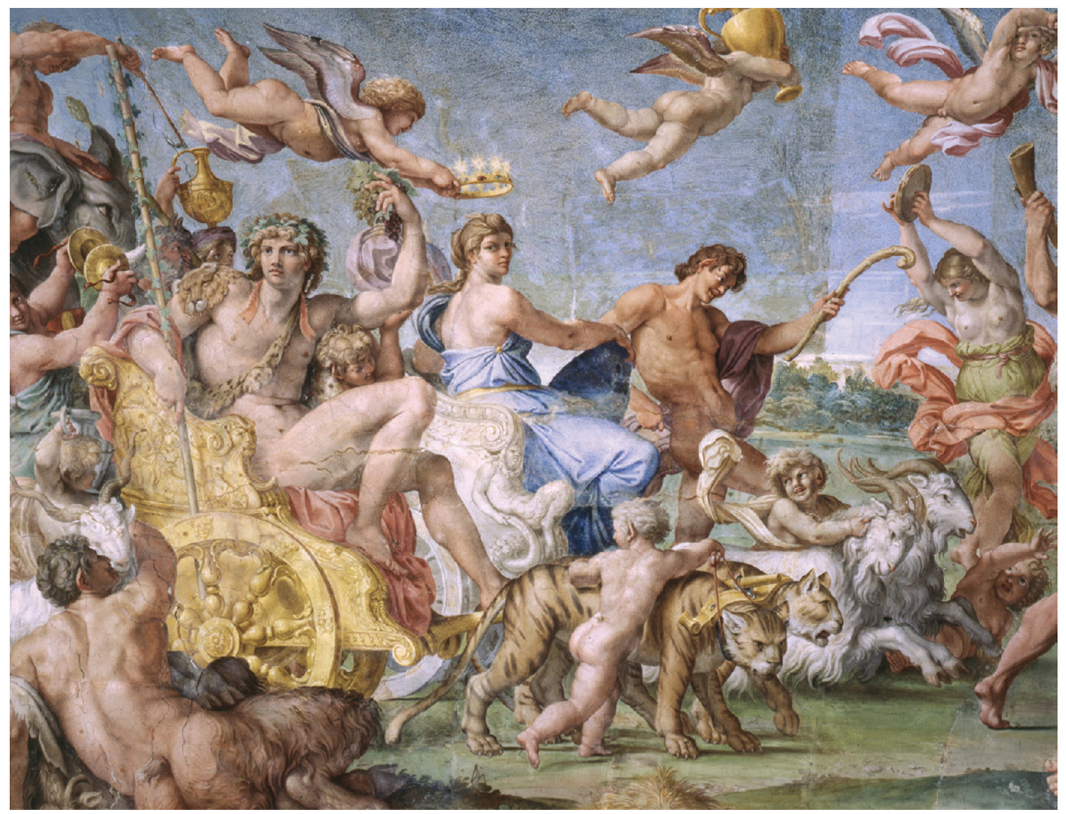
Figure 24: Annibale Carracci, The Triumph of Bacchus and Ariadne , 1595. Detail. Palazzo Farnese, Rome.